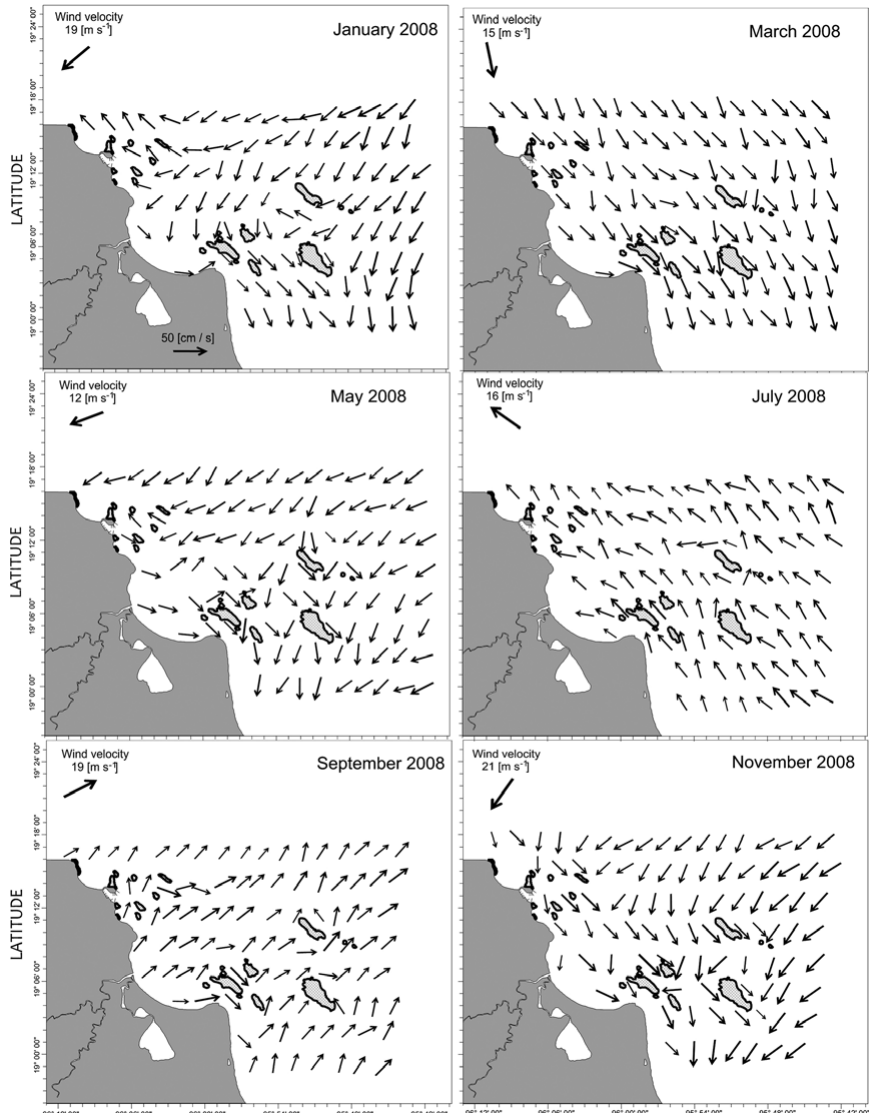
Fig. 2. – Residual surface (1 m depth) current velocities and the two-day average wind velocity on 18 January, 21 March, 16 May, 18 July, 19 September and 21 November